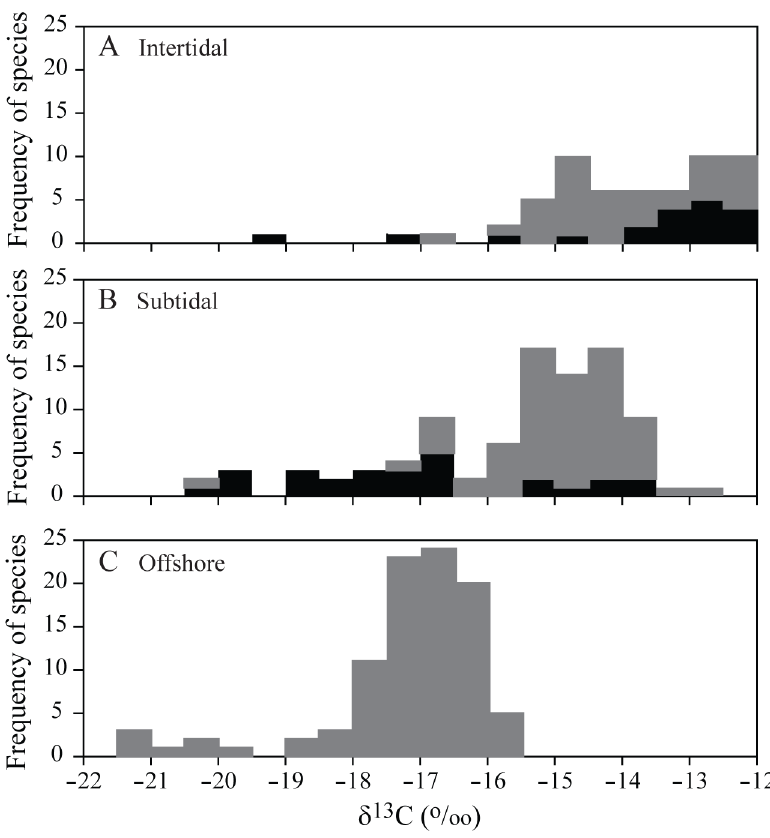
Fig 6. Frequency distribution of individual consumer δ 13 C ( ‰ ) collected in (A) intertidal, (B) subtidal, and (C) offshore habitats. Gray bar segments represent motile consumers and black bar segments sedentary